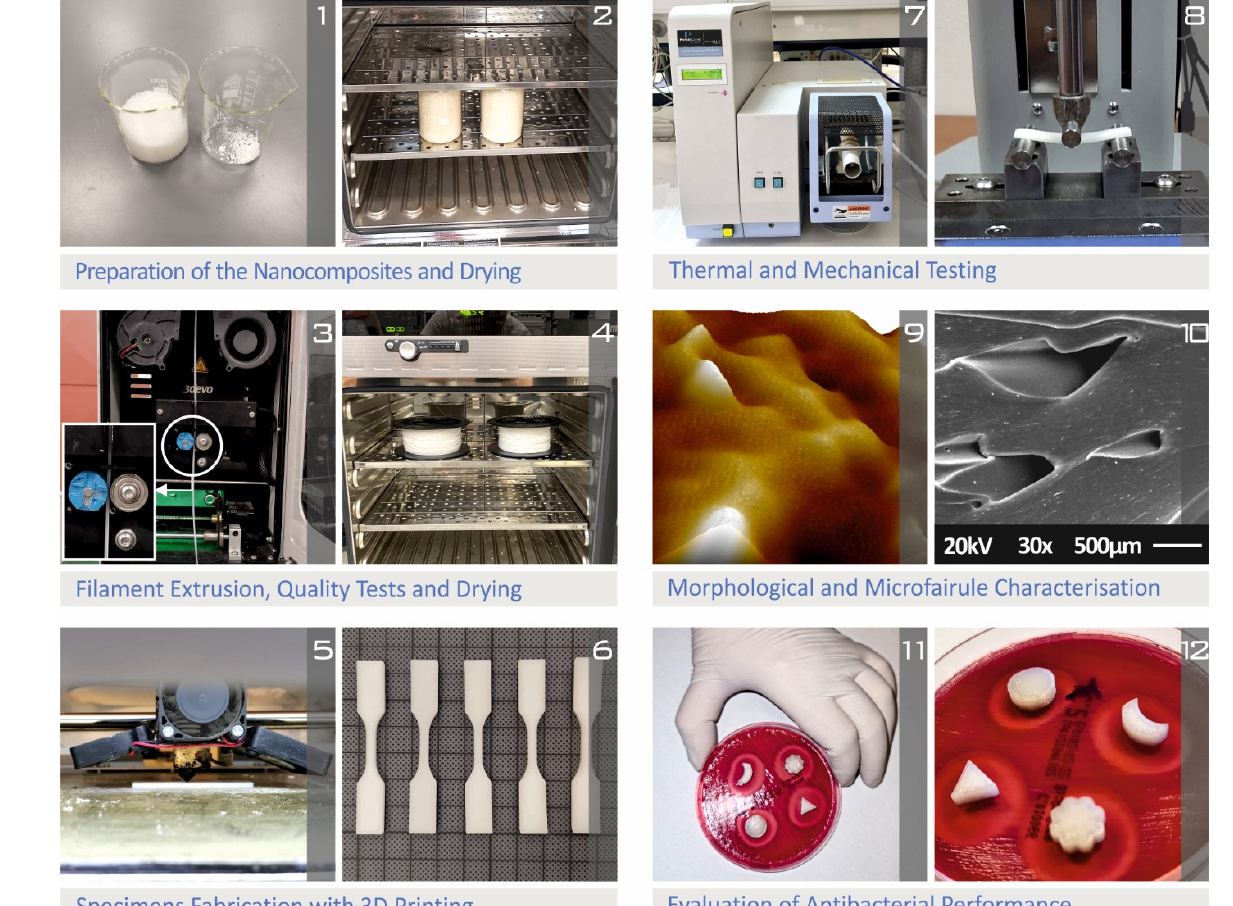
Figure 1. Presentation of the overall procedure followed for the preparation, measurement, and characterization of PA12/AgDANP nanocomposites: ( 1 ) matrix material and filler powder; ( 2 ) after the mixture of the matrix material and the nano-filler, nanopowders are dried; ( 3 ) the filament extrusion process; ( 4 ) the filament drying process; ( 5 ) specimens’ 3D printing process; ( 6 ) tensile testing of specimens; ( 7 ) investigation of nanocomposites’ thermal properties in the thermogravimetric analysis device; ( 8 ) flexural testing of the manufactured specimens; ( 9 ) filament surface roughness investiga- tion in the atomic force microscopy device; ( 10 ) investigation of specimens’ surface morphology in scanning electron microscopy device; ( 11 , 12 ) investigation of the antibacterial performance of the nanocomposites for E. coli bacterium with the agar well diffusion screening